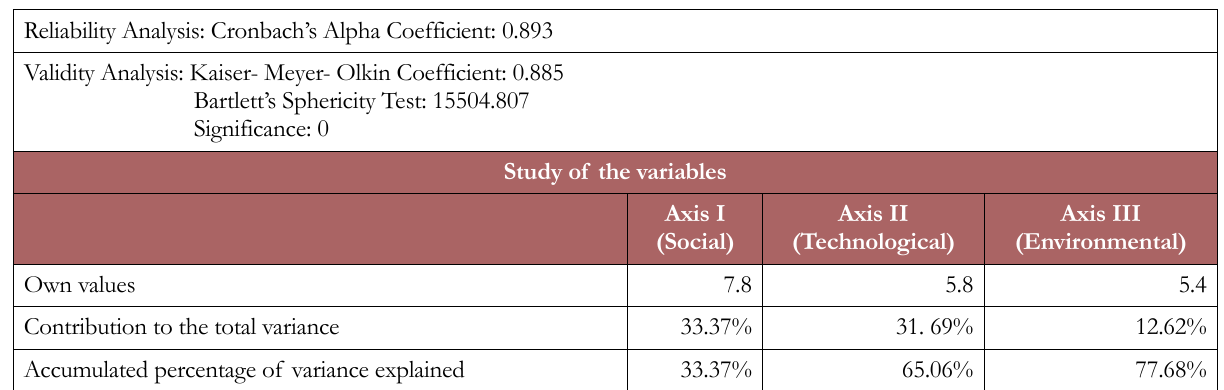
Table 2. Results of the factorial analysis of correspondences for the TS